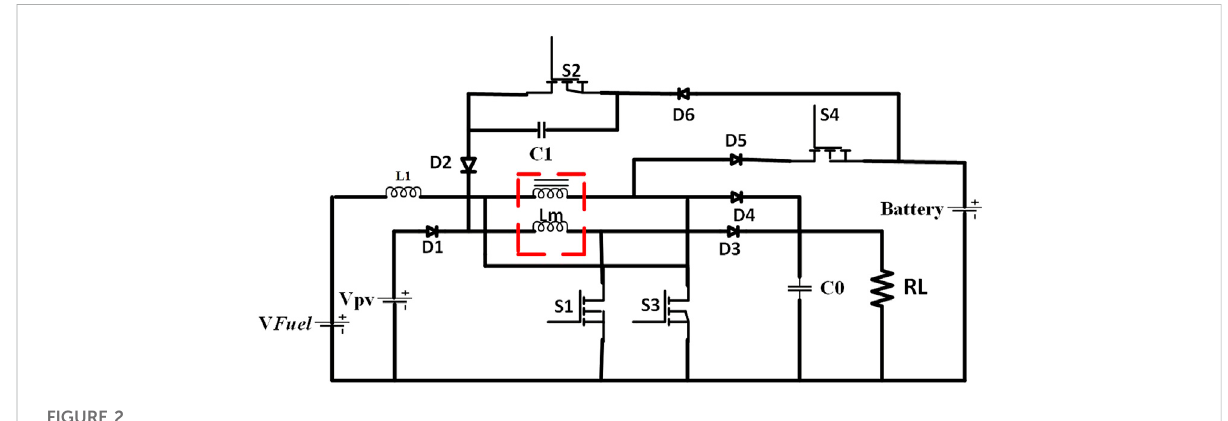
FIGURE 2 Interleaved multi-input converter with